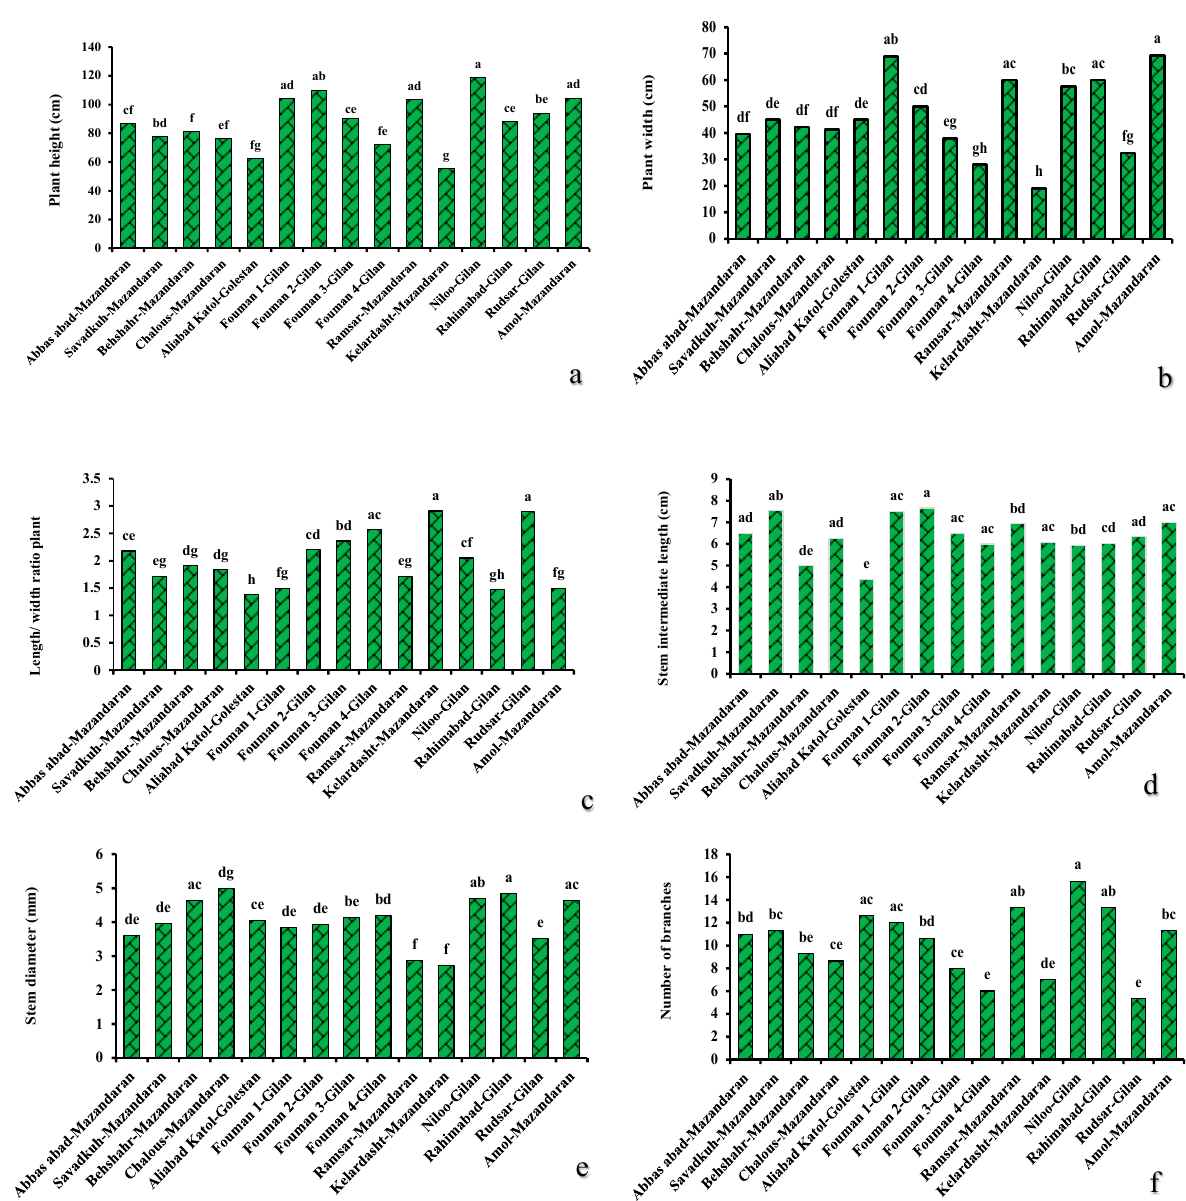
Figure 2. Mean comparisons for plant height ( a ), plant width ( b ), height-to-width ratio ( c ), internode length ( d ), stem diameter ( e ), and lateral branch number ( f ) of 15 different ecotypes of M. aquatica collected from the Hyrcanian hotspot of Iran. Different letters indicate significant differences according to the LSD test at p < 0.05.